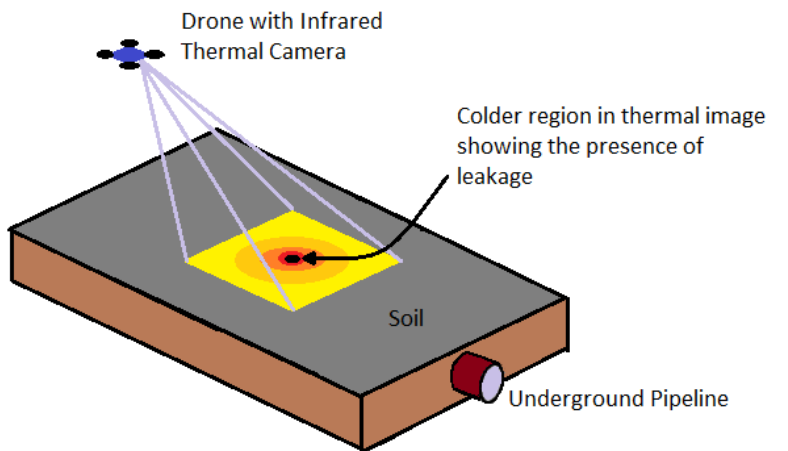
Figure 48. Thermal imaging of underground pipelines using a drone equipped with a thermal camera. Modified from